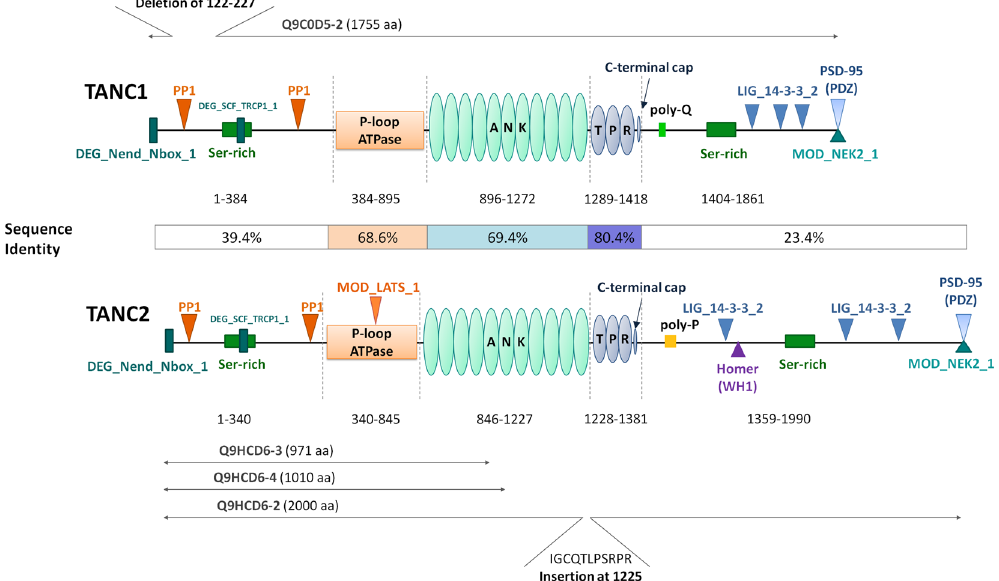
Figure 1. Sequence analysis of TANC proteins. An overview of TANC family domain architecture is here reported. Both TANC proteins are characterized by a putative P-loop NTPase domain (orange), an Ankyrin repeat containing domain (light teal) and a tetratricopeptide repeat region (blue). For each domain, the sequence boundaries and sequence identity between the two proteins are indicated. Conserved linear motifs are represented as follow: PDZ binding sequences (light blue triangles); PP1 docking motif (RVxF) (orange triangles); degrons (DEG_Nend_Nbox_1 and DEG_SCF_TRCP1_1) (deep teal rectangles); 14_3_3 binding sites (LIG_14-3-3_2) (blue triangles); Homer binding motif (LIG_EVH1_1) (Purple triangle); LATS1 kinase (light orange triangle); NEK2 phosphorylation motif (MOD_NEK2_1) (Teal triangle). Serine-rich regions are represented with green rectangles (TANC1 residues 170-243 and 1659–1689; TANC2 residues 125–189 and 1775–1865). The TANC1 glutamine-rich region (poly-Q) region and TANC2 glutamine/proline rich region (polyP) are in light green and yellow respectively. Alternative TANC protein isoforms are reported in grey. The TANC1 isoform Q9C0D5-2 (1755 residues) is missing the region 122-227. The TANC2 isoform Q9HCD6-2 is longer (2000 residues) due to an insertion at position 1225 (I > IGCQTLPSRPR). Q9HCD6-3 (971 residues) is truncated at residue 97 with different substitution in the region from position 944 to 971 (VDHLDKNGQCALVHAALRGHLEVVKFLI > VLAAQLCCFSSLFLYFRCILFLISSVTS). Q9HCD6-4 (1,010 residues) is truncated at residue 1011 with different substitution in the region from position 1006 to 1010 (IVSYL >